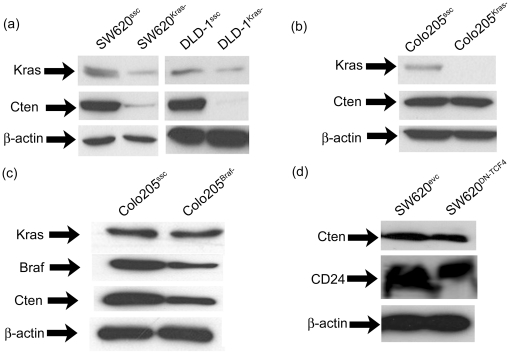
Functional relationship between Kras and Cten.(a) Knockdown of Kras in SW620 and DLD1 (both mutant for KRAS) resulted in a down-regulation of Cten levels (SW620Kras- versus SW620ssc-, DLD1Kras- versus DLD1ssc-). In contrast, (b) shows that Kras knockdown in Colo205 (containing a BRAF V600E mutation) had no effect on Cten expression (Colo205Kras- versus Colo205ssc) whilst (c) shows that knockdown of Braf in Colo205 did cause down-regulation of Cten (Colo205Braf- versus Colo205ssc). Figure (d) shows that inhibition of Wnt signalling in SW620 with a dominant-negative TCF4 expression vector (SW620DN-TCF4) did not alter Cten levels compared with empty vector (SW620evc) whilst levels of CD24 (a known target of Wnt signalling) were reduced.